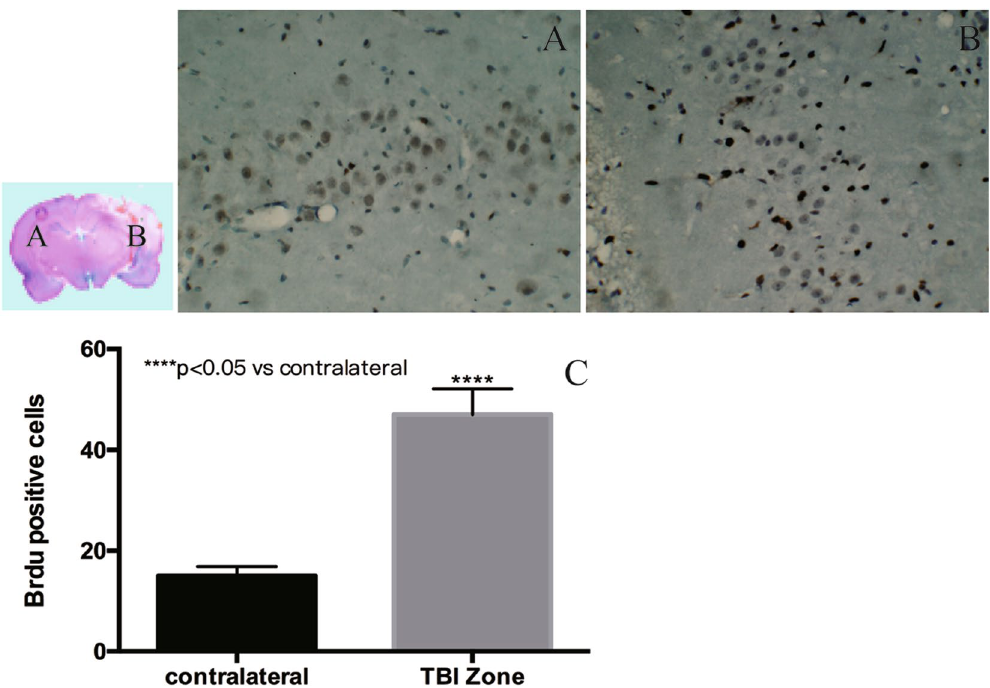
Figure 6. Distribution of BrdU-positive EPCs. Seven days after tail vein transplantation of EPCs, several BrdU- positive EPCs were detected in the TBI zone, and few BrdU-positive EPCs were detected in the contralateral hemisphere. BrdU-positive cells were significantly higher in the ipsilateral hemisphere as compared to the contralateral hemisphere (P <